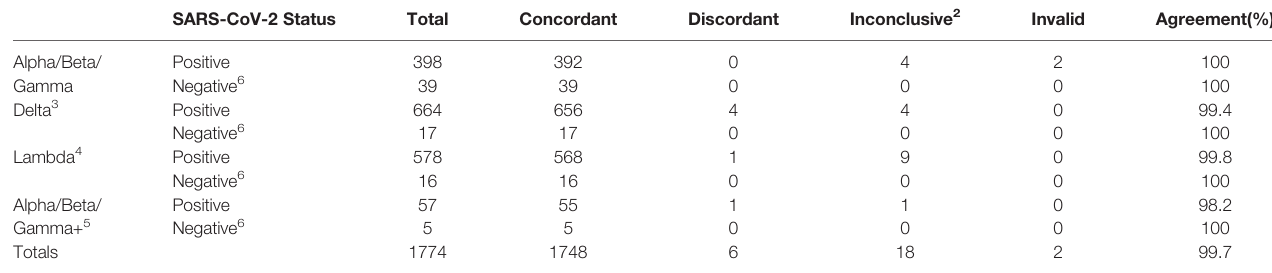
TABLE 3 | Accuracy of the SARS-CoV-2 PlexPrime assays relative to WGS 1